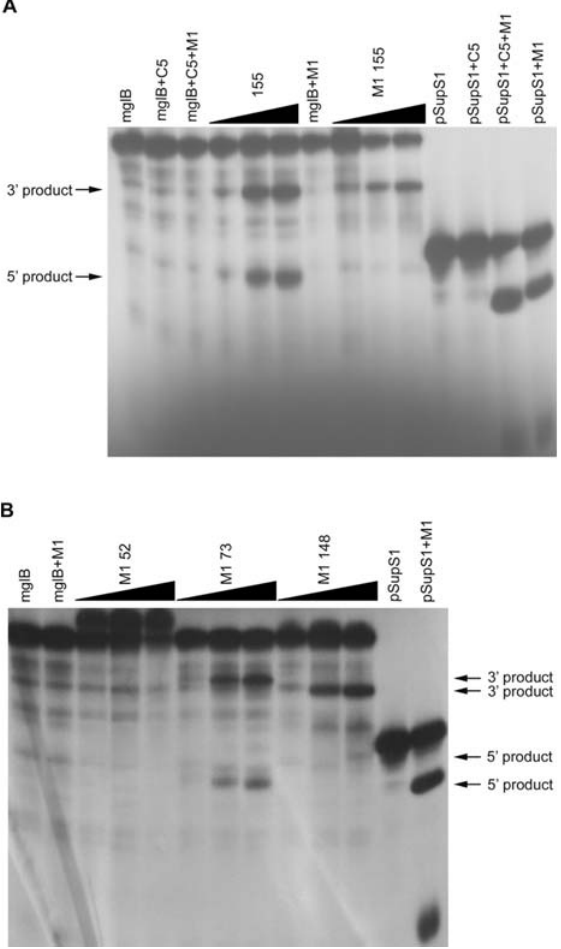
Figure 2. Cleavage invitro of the mglB mRNA by the RNase P holoenzyme in the absence or presence of stem EGSs. A. Activities of stem EGS155 and EGS155R. B. Activities of stem EGS52, EGS73, and EGS148. If needed, 10 nM M1 RNA and 100 nM C5 protein in buffer PA were added to reconstitute the RNase P holoenzyme. The mglB mRNA cleavage products were separated on 8% polyacrylamide/ 7 M urea gels along with the mglB mRNA alone or the mglB mRNA with the RNase P holoenzyme. Internally labeled pSupS1 ptRNA was used as a positive control to check for activity of the reconstituted RNase P holoenzyme. EGSs were added in 100-, 50-, and 10-fold molar excess to the mglB mRNA, denoted by black triangles. doi:10.1371/journal.pone.0003719.g002 (Fig. 2A, 2B, 3A, and 3B). Consistent with the results of stem EGSs, only M1 EGSs targeting positions 73, 148, and 155 cleaved the mglB mRNA. Increase of the M1 EGSs concentration resulted in increase of the amount of cleavage products (Fig. 3A and 3B).